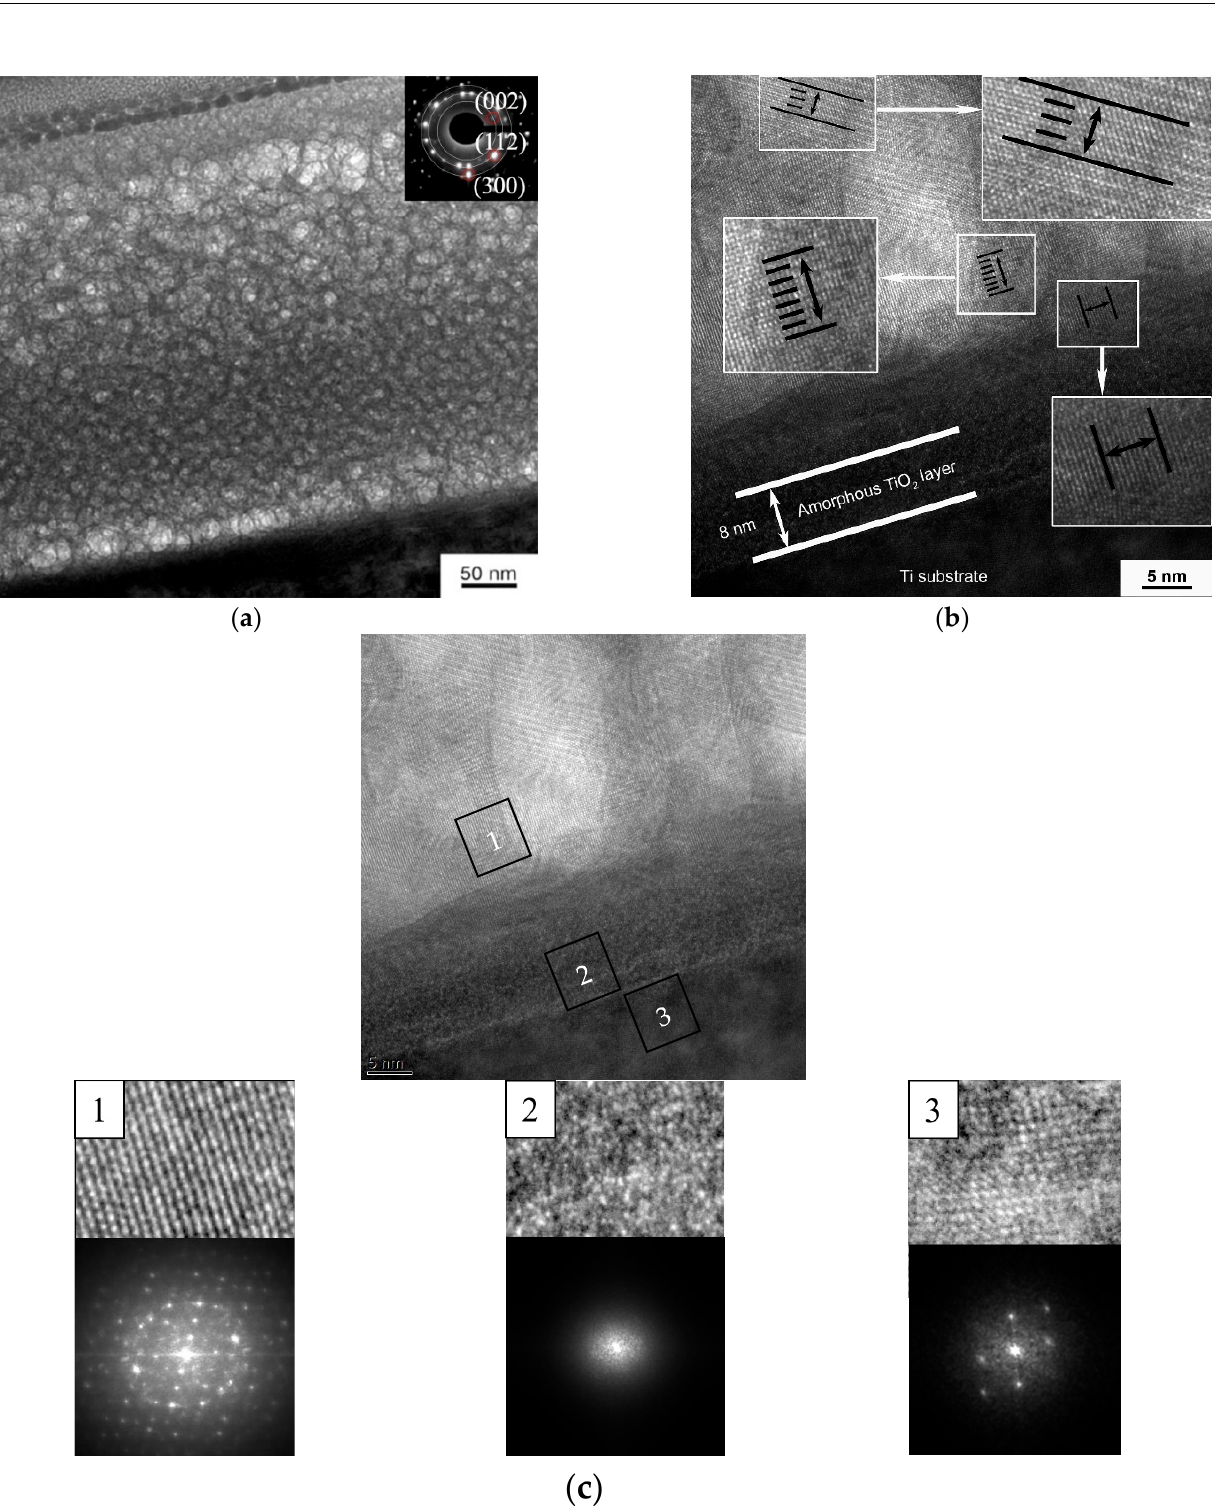
Figure 12. TEM image of the cross-section of Zn-HA coating on an NS Ti substrate with the corresponding SAED ( a ), high-resolution TEM image of the interface between the substrate and the coating ( b ), as well as the structure of coating areas (1), interface between the substrate and the coating (2) and substrate material (3) with the corresponding Fourier-transform image ( c ). The Ca/P ratio was obtained by EDX mapping of the coating area and was 1.4. The Zn concentration was also small, as in the case of ACP, and did not exceed 0.3 at.%. This Zn concentration is close to the detection limit for the EDX method and can only indicate the presence of this element, but not its quantity in the material.